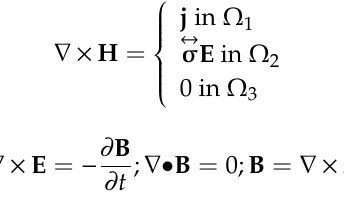
Figure 8. 3D MFT model divided into three computational domains: Ω 1 volume of the windings (orange), Ω 2 volume of the homogenized core (grey) and Ω 3 air surrounding the MFT (white).